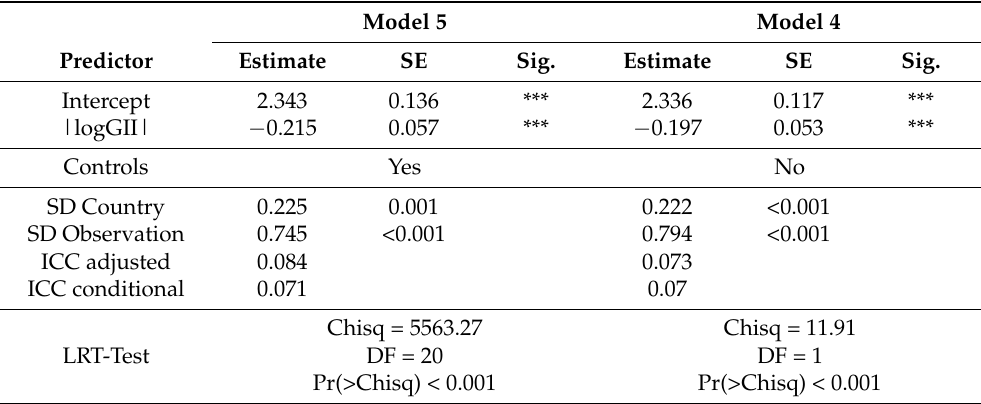
Figure 1. Marginal effects of partnership on loneliness at representative levels of gender equality (based on Model 3). Table 3. Multilevel linear models of effect of GII on SNI stress .